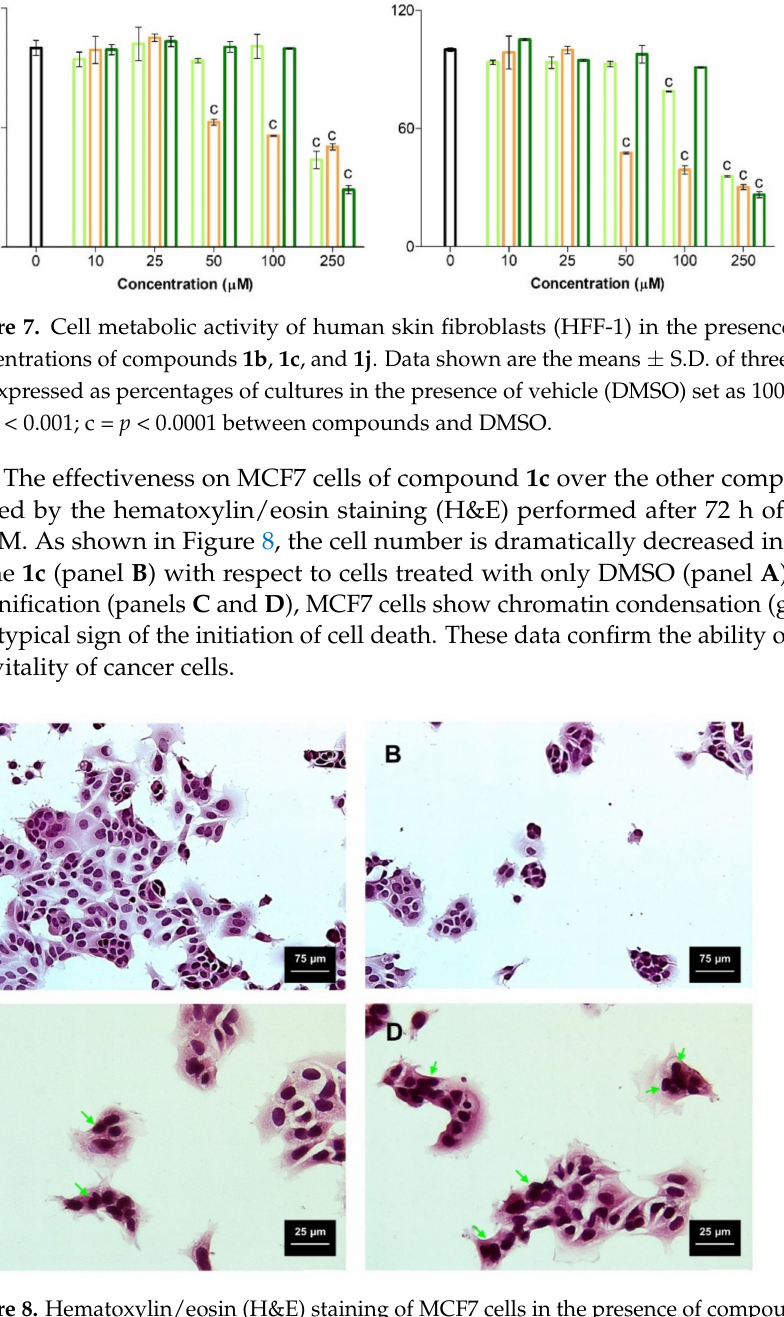
Figure 8. Hematoxylin/eosin (H&E) staining of MCF7 cells in the presence of compound 1c at 50 µ M after 72 h. A = 0 µ M; B , C , and D = 50 µ M compound 1c . Magnification 200 × ( A , B ) and 400 × ( C , D ). The bar scales represent 1 cm = 75 µ m and 25 µ m, respectively. Cell nuclei are stained in purple, and the cytoplasm fraction is pink-stained. Green arrows indicate chromatin